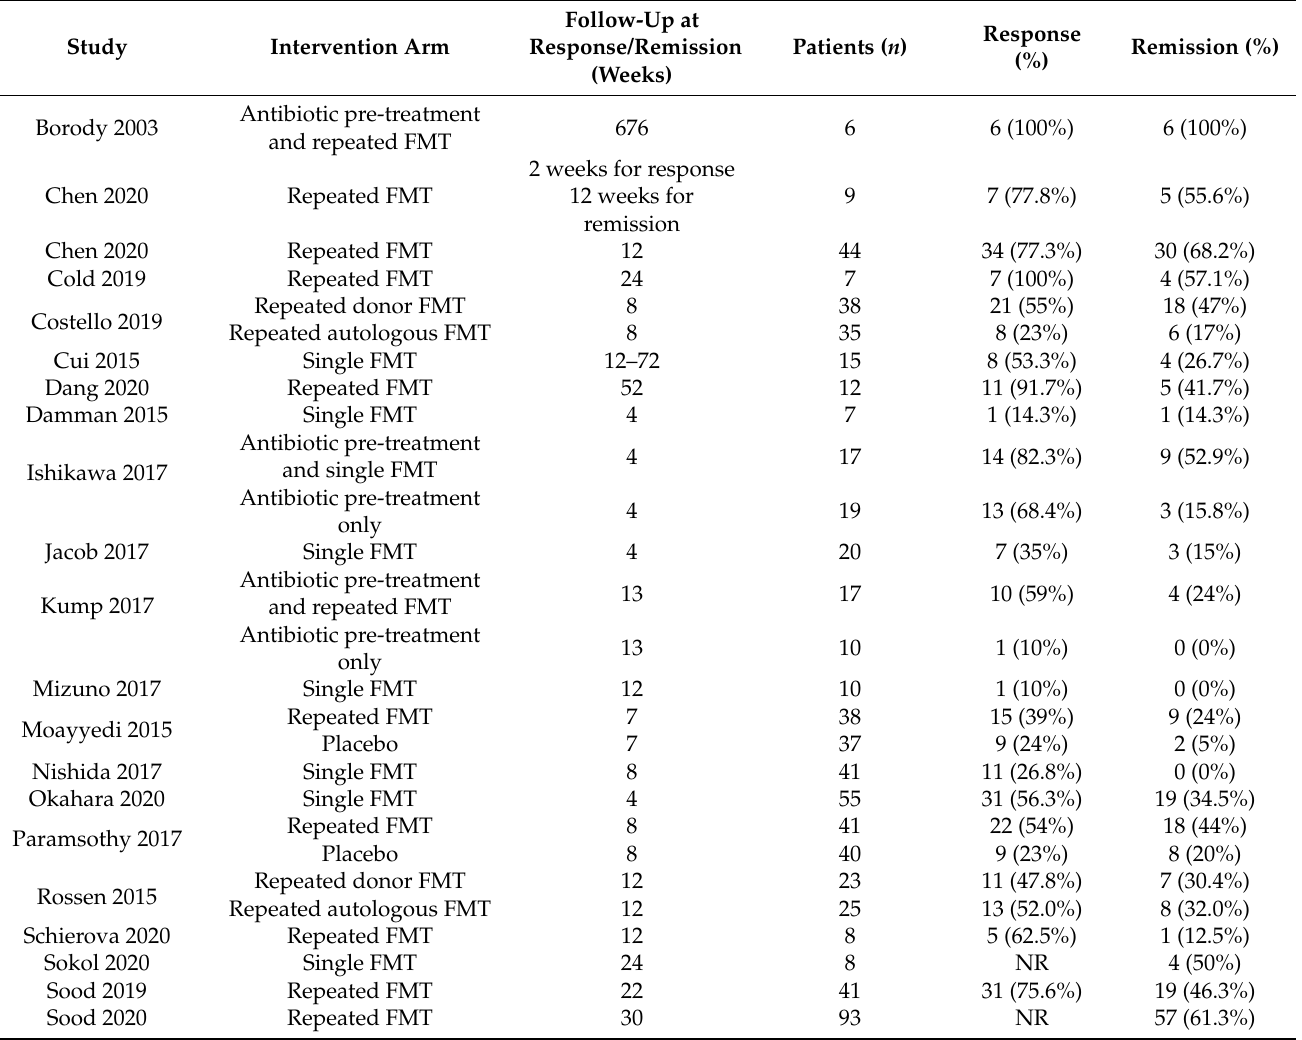
Table 3. Response and remission rates for included